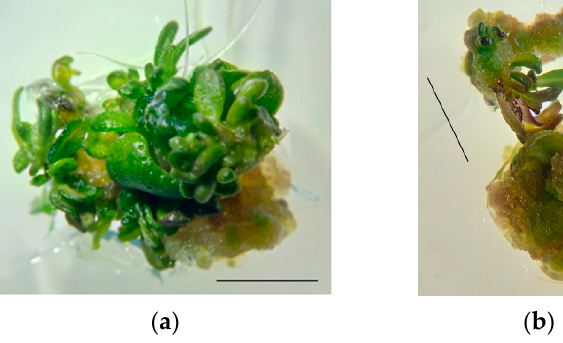
( f ) Figure 3. Changes in the appearance of S. hortensis callus tissue over six subcultures: ( a ) 1st subcul- ture, ( b ) 2nd subculture, ( c ) 3rd subculture, ( d ) 4th subculture, ( e ) 5th subculture, and ( f ) 6th sub- culture. Bars—0.5 cm.